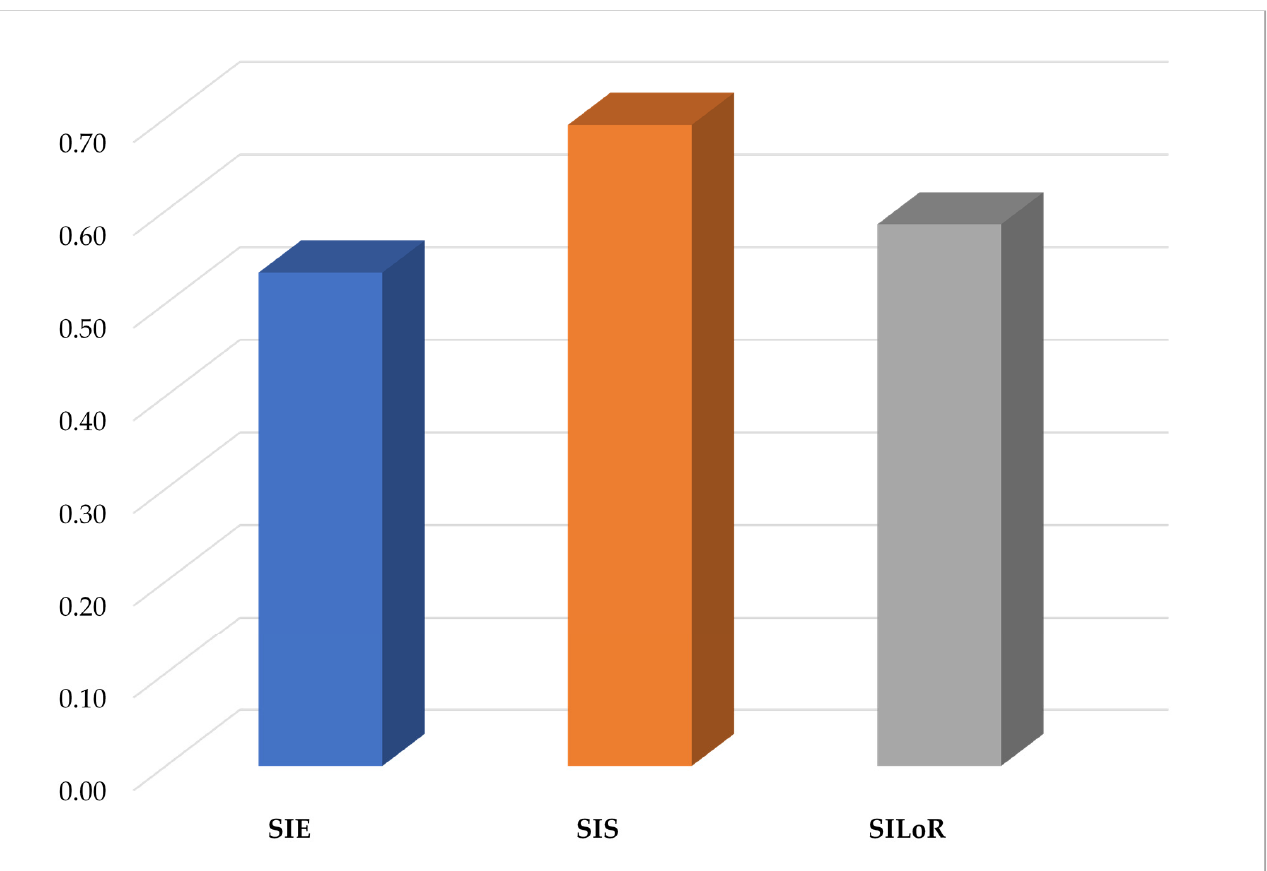
Figure 4. Contribution of vulnerability sub-indices in the FVI across the study area.